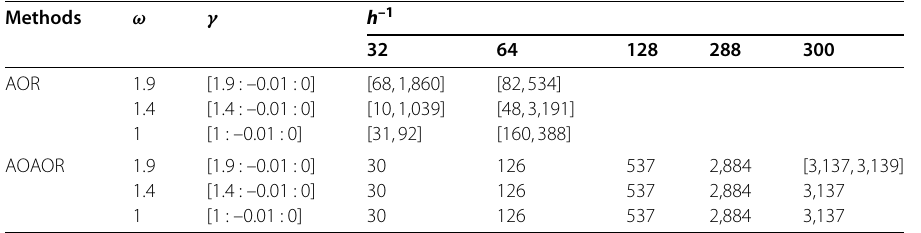
Table 9 The gap of IT when ξ = 0.0, ζ = 30.0, σ = 10.0 ( ε = h 2 )